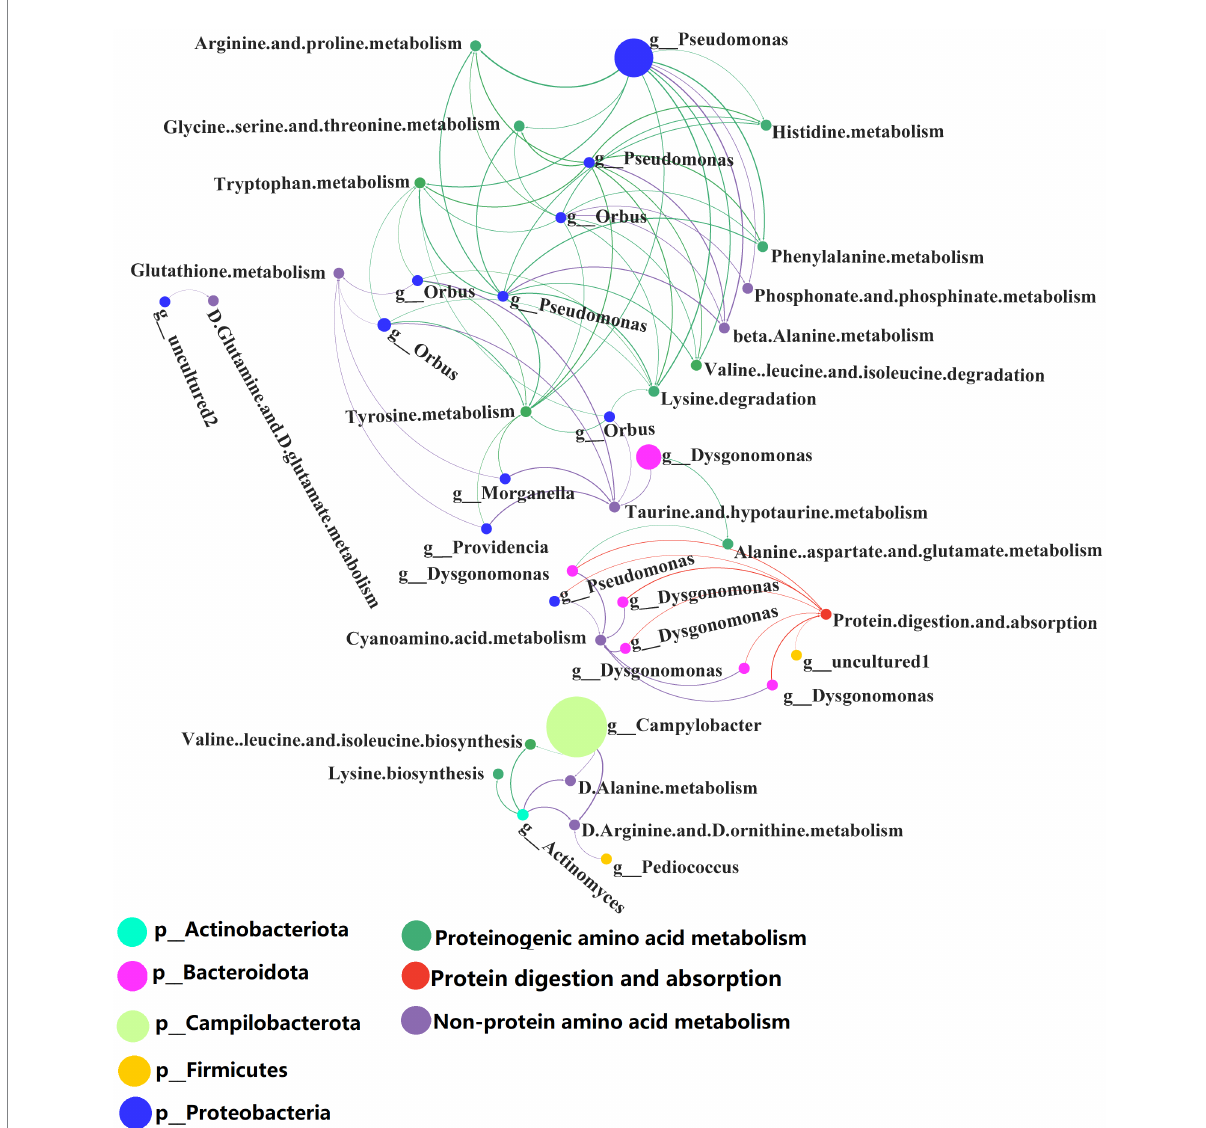
FIGURE 7 Network analysis of the co-occurrence patterns of protein metabolism and 16S rDNA amplicon (genus level) during conversion to artificial diets. Node size was proportional to node abundance; edge represents interactions between nodes. Sizes of connecting lines are based on r values. Nodes are colored for gut microbes, amino acid metabolism, metabolism of other amino acids and protein digestion and absorption, respectively. A connection was based on Spearman’s correlation coefficient ( R > 0.6, p < 0.05). The average number of neighbors for this network is 4.625; characteristic path length is 4.159; network density is 0.149; and the clustering coefficient is